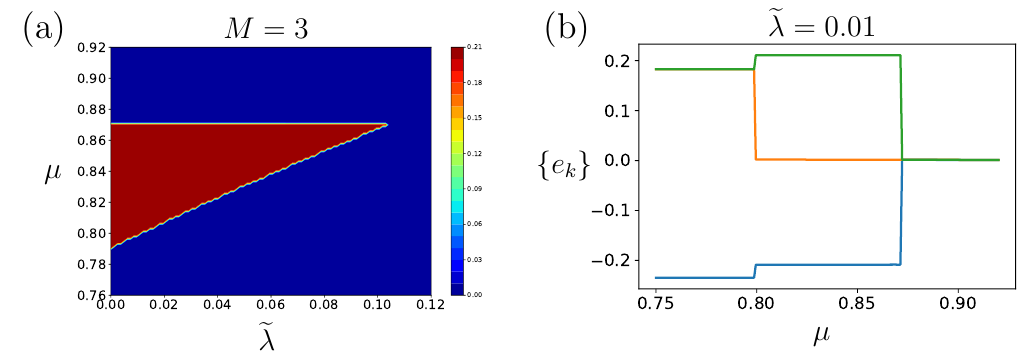
Figure 14 . (a) The T = 0 phase diagram for M = 3 with observable is Min ( | e 1 − e 2 | , | e 2 − e 3 | , | e 3 − e 1 | ) . Within the red triangle the three e k differ from one another, indicating spontaneous symmetry breaking U (3) → U (1) 3 . (b) The µ -dependence of { e k } at e λ = 0 . 01 . There is a range of µ in which the three e k are all different.